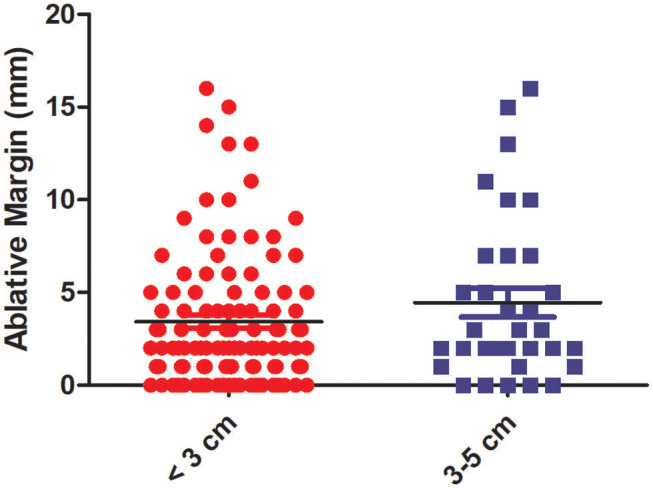
The correlation between the minimal (ablative margin) AM and tumor size. The histogram shows that there is no statistical difference in the AM between the <3-cm group and 3–5-cm group.